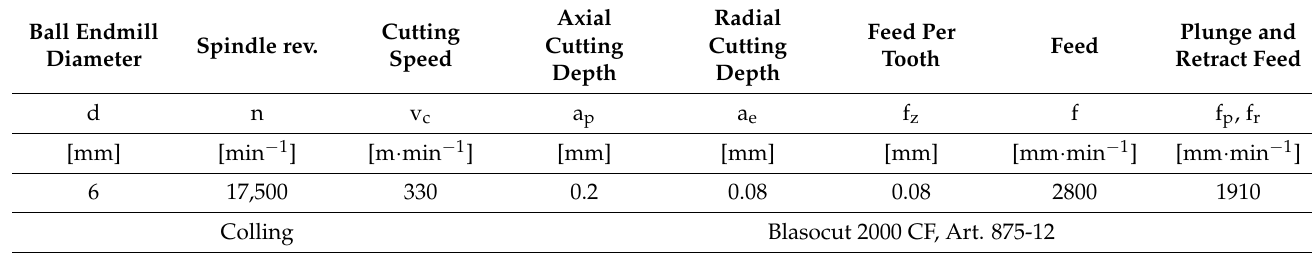
Table 2. Cutting conditions of finishing operation.